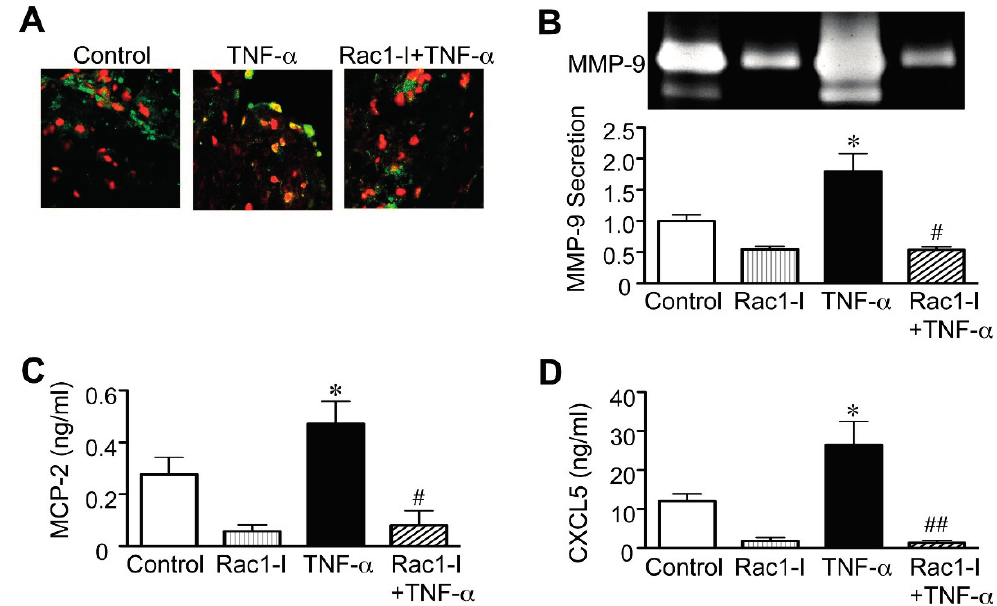
Figure 5. Effect of Rac1 inhibitor on human abdominal aortic aneurysm (AAA) wall. A human AAA wall was cut into small pieces and cultured with the Rac1 inhibitor NSC23766 (Rac1-I, 100 μ M), tumor necrosis factor (TNF)- α (50 ng/mL) or vehicle (control). ( A ) Nuclear translocation of nuclear factor (NF)- κ B in cultured tissues was analyzed by immunofluorescence staining. Representative results are shown for NF- κ B (green) and cell nuclei (red). Yellow indicates overlapping localization of the red and green signals; ( B – D ) Levels of matrix metalloproteinase (MMP)-9, monocyte chemoattractant protein (MCP)-2 and epithelial neutrophil-activating peptide (CXCL5) in the conditioned media were analyzed ( n = 4). Data are the mean ± standard deviation. * p < 0.05 compared to the control; # p < 0.05 and ## p < 0.01 compared to TNF- α